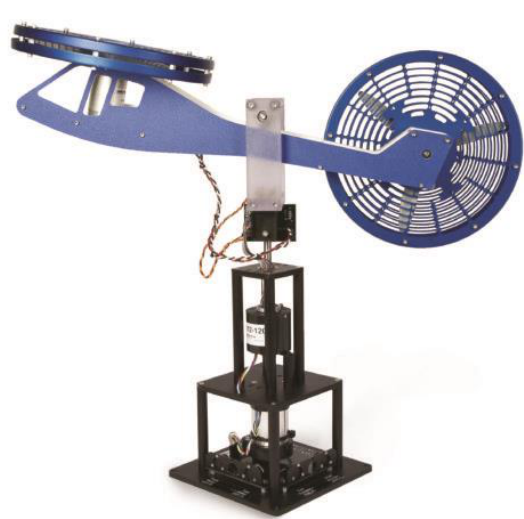
Figure 2. Helicopter 2-DOF Quanser ® .